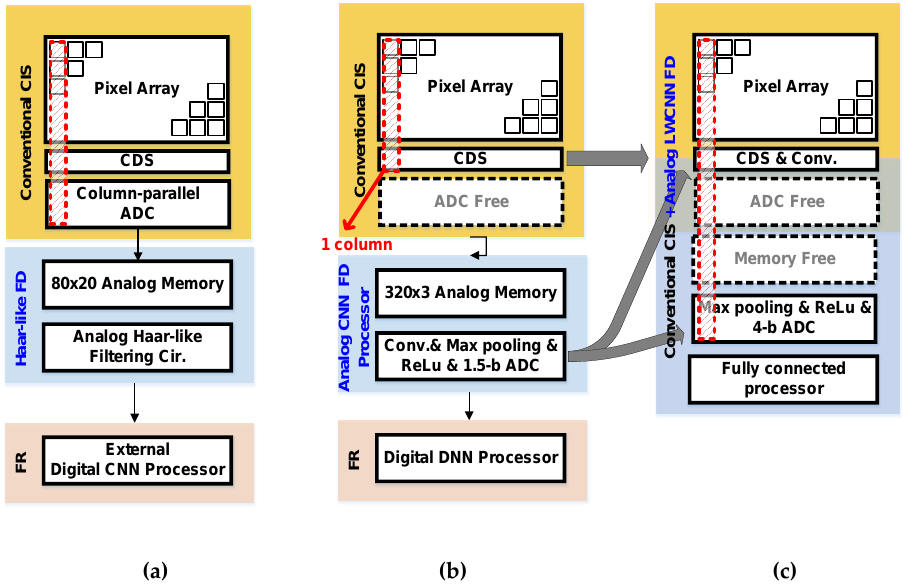
Figure 2. Different types of face detection (FD) system architectures for ( a ) Haar-like FD [12], ( b ) analog–digital hybrid CNN FD [13], and ( c ) the proposed analog lightweight CNN (a-LWCNN) FD.